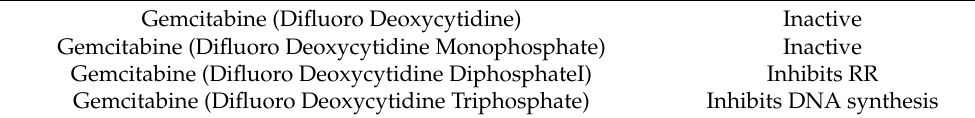
Figure 6. The mechanism of action of gemcitabine is by competing with deoxycytidine. Incorporation of gemcitabine into the DNA strand introduces an irreparable error that the cell cannot circumvent. This faulty DNA unleashes apoptotic mechanisms. A high level of deoxycytidine may prevail over gemcitabine, reducing its effects. The DNA synthesis mechanism is over-simplified in the diagram, the objective of which is to show how an increased glycolytic flux participates in resistance to gemcitabine. Lonidamine, which significantly decreases glycolysis, is probably good to associate with gemcitabine to prevent resistance, although this has not been tested. Increased expression of ribonucleotide reductase, specifically the M1 isoform, is also an important participant in resistance. Table 2. Activity of metabolic intermediaries of gemcitabine.